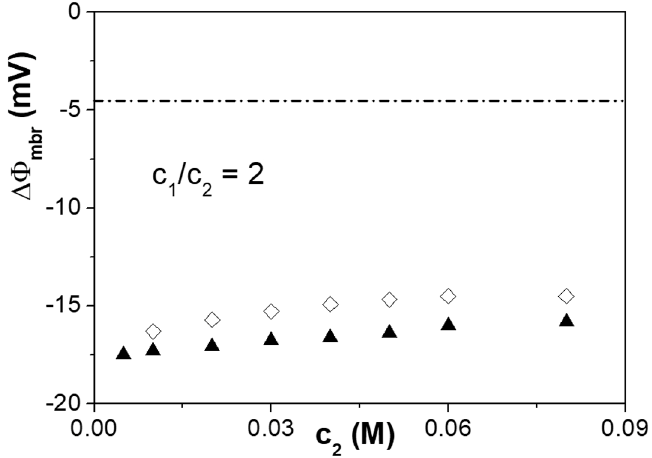
Figure 2. Membrane potential as a function of NaCl solution concentration: ( ◊ ) 26% AlqCl/74% CTA membrane, ( ▲ ) ion-exchanger AR204-SZRA-412 membrane. Solution diffusion potential: dash dot line.